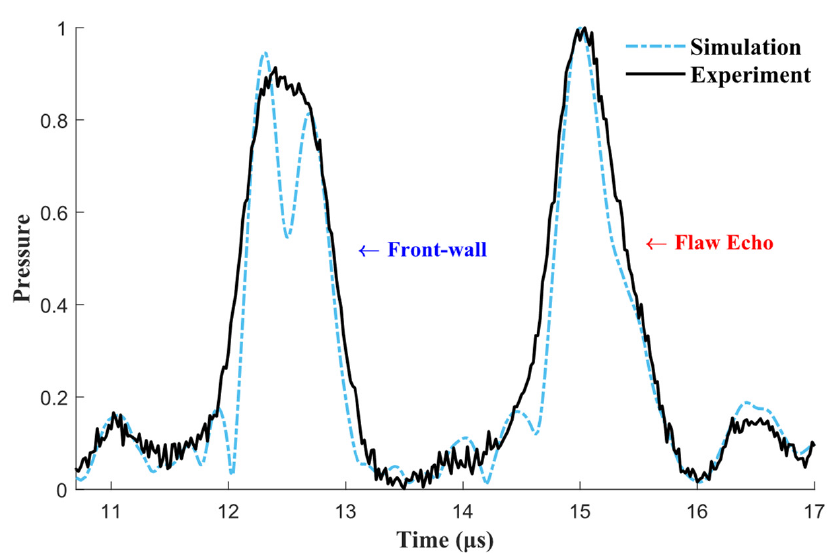
Figure 8. Pulse-echo signal when the notch is at 45° (normalized with the amplitude of each flaw